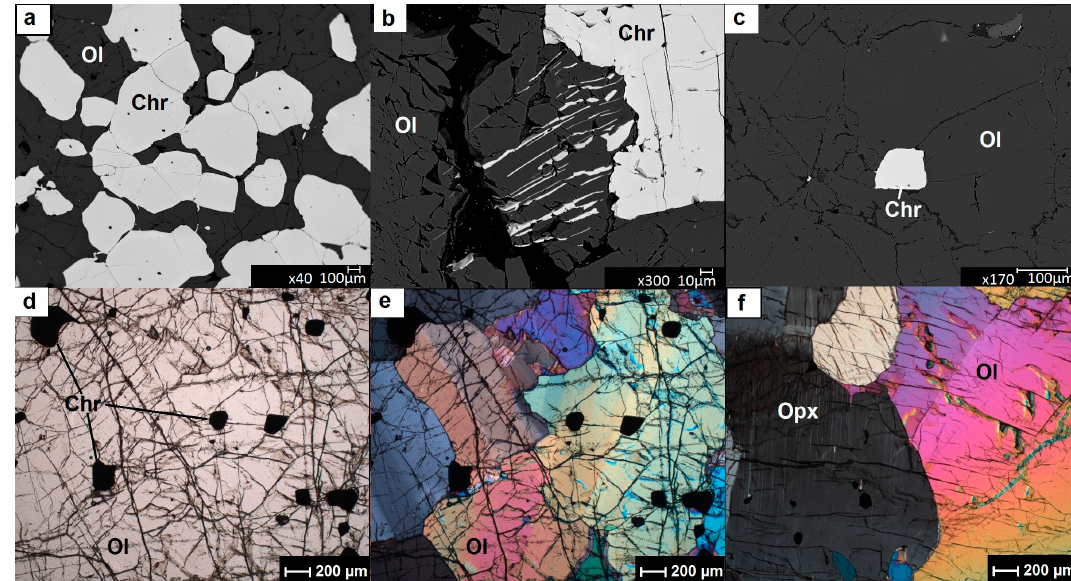
Figure 2. Chromitites and dunites from Rio Creves and Polunia. ( a ) BSE (Back Scattered Electrons) image of a chromitite (Polunia); ( b ) BSE image of chromite growth within an olivine crystal (Rio Creves); ( c ) BSE image of a disseminated chromite crystal in dunite (Rio Creves); ( d ) disseminated spinels within olivine crystals, transmitted light (1N); ( e ) disseminated spinels (black) within olivine crystals, transmitted light (2N); ( f ) pyroxene and olivine crystals, transmitted light (2N). Mineral abbreviations are according to Whitney et al. [20].